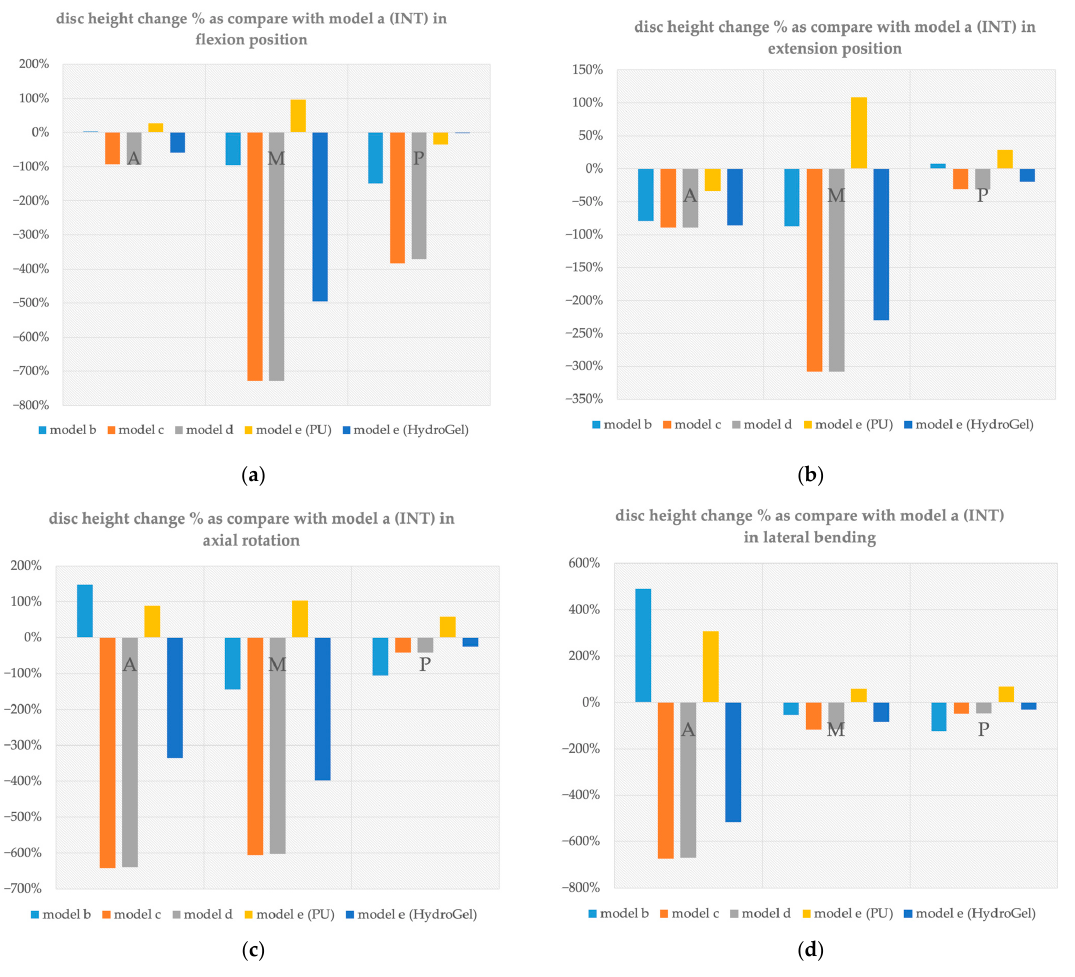
Figure 4. Change in intervertebral disc height at the anterior (A), posterior (P), and medial (M) sides of the disc as a percentage of the intact model (model a, INT) for ( a ) flexion, ( b ) extension, ( c ) axial rotation, and ( d ) lateral bending motions.